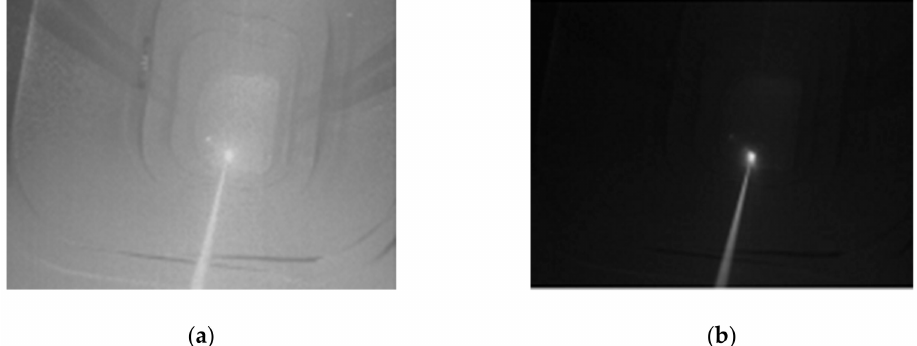
Figure 7. CCD camera imaging of the laser hitting a CCR. The exposure time of the CCD camera was set to 8400 µ s in ( a ) and 500 µ s in ( b ).